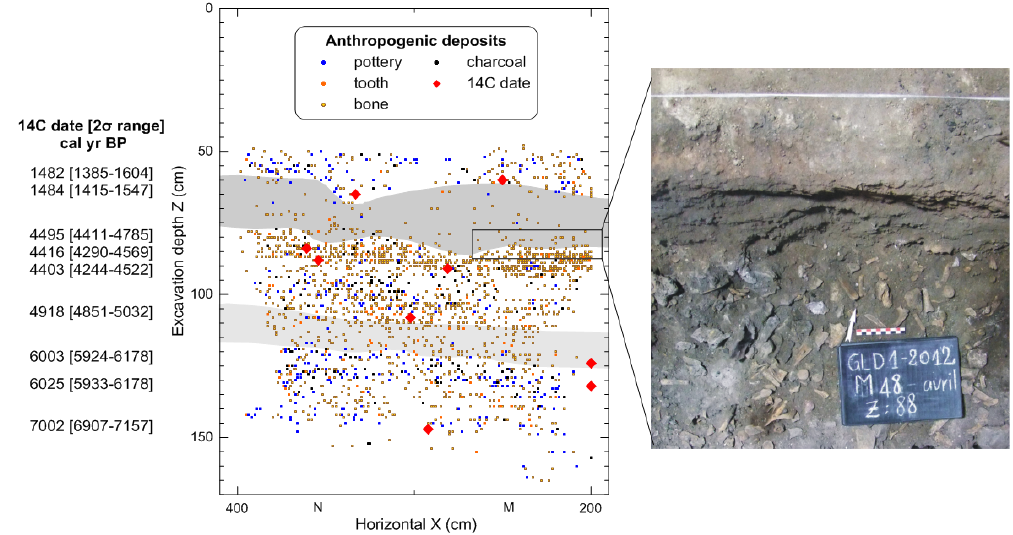
Figure 6. Radiocarbon dating of anthropogenic deposits layers in excavation sector S2 inside the Gueldaman GLD1 Cave. From the left to right are 14 C dates of charcoal samples, anthropogenic deposit distribution, and a photo at depth across ∼ 75–88cm showing a transition of layer from rich to rare anthropogenic deposits. The gray color highlights two phases with diminished anthropogenic remains (especially pottery and charcoal) at ca. 4403–1484calyrBP (depths of ∼ 75–60cm) and ca. 6003–4918calyrBP (depths of ∼